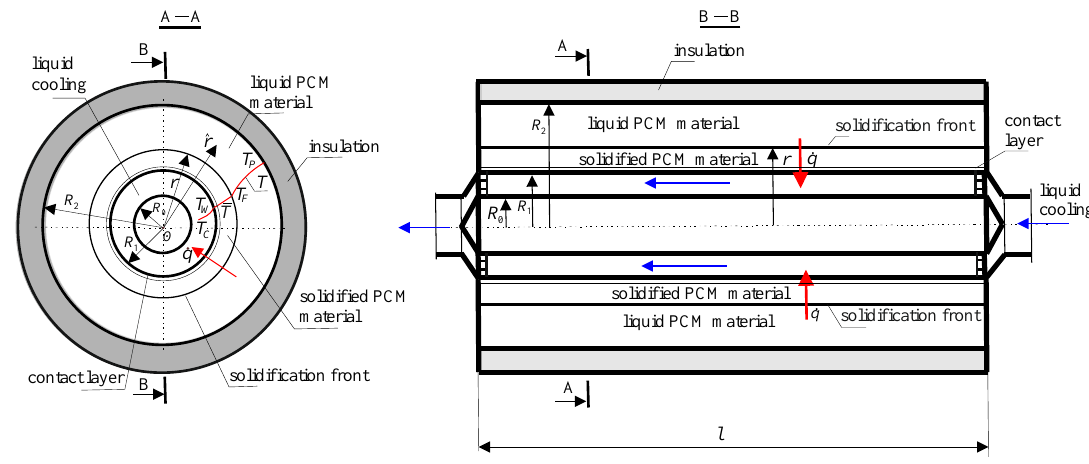
Figure 1. Solidification in an annular space. PCM: phase change material.